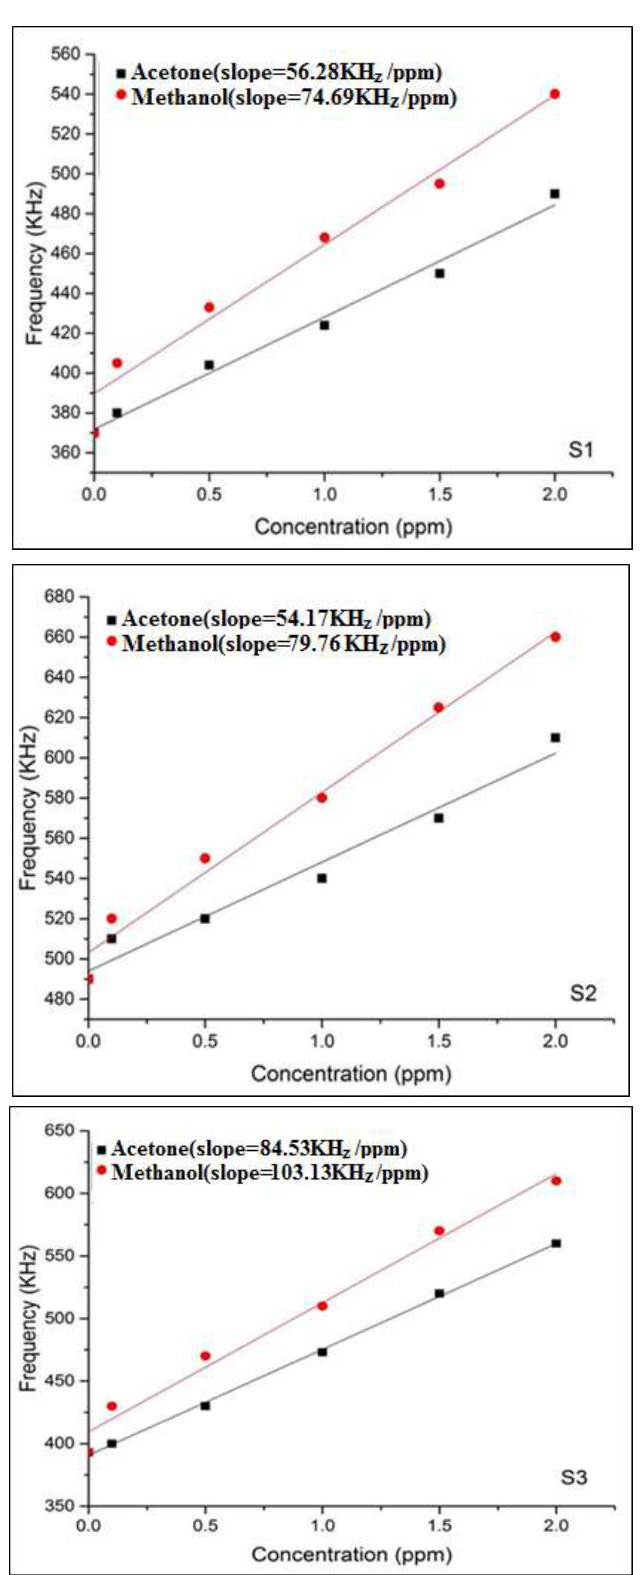
Figure 8: Dependence of resonant frequency (f) on methanol and acetone concentrations (0.1ppm to 2ppm) for S 1 , S 2, and S 3